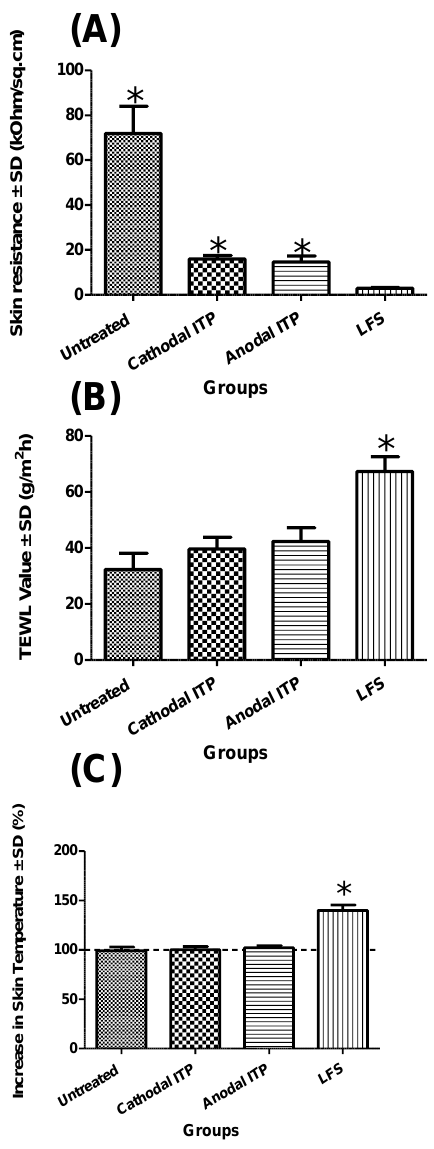
Figure 3. ( A ) Electrical resistance, ( B ) transepidermal water loss, and ( C ) increase in the temperature of dermatomed human cadaver skin (* indicated statistical difference from the LFS, mean ± SD, n = 4, p < 0.05).